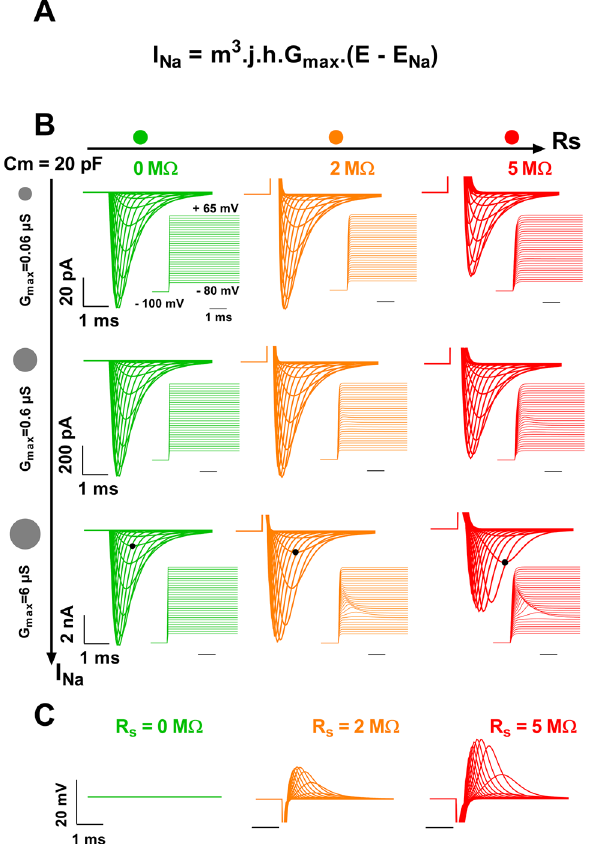
Figure 2. Kinetic model of cardiac I Na current (Na v 1.5)—computed effects of increasing series resistance and current amplitude range on current recordings. (A) Expression of the Na + current depending on the activation gate (m 3 ), inactivation gate (j.h), the maximal conductance (G max ) and the reversal potential for Na + (E Na ) 5,16 . ( B) Superimposed computed I Na , for increasing current amplitude range (I Na , see vertical scales, top to bottom) and series resistance (R S , left to right). The activation voltage protocol shown (in inset, holding potential: − 100 mV; 50-ms pulse at the indicated potentials; one sweep every 2 s) corresponds to the potential at the membrane, not the command potential between the two electrodes. It is thus altered when (R S x I) is elevated, its maximum deflection reaching 26 mV at V cmd = − 40 mV (cf text). ( C) Superimposed computed voltage deviation for the highest amplitude (10 nA) and various Rs, as in (B)